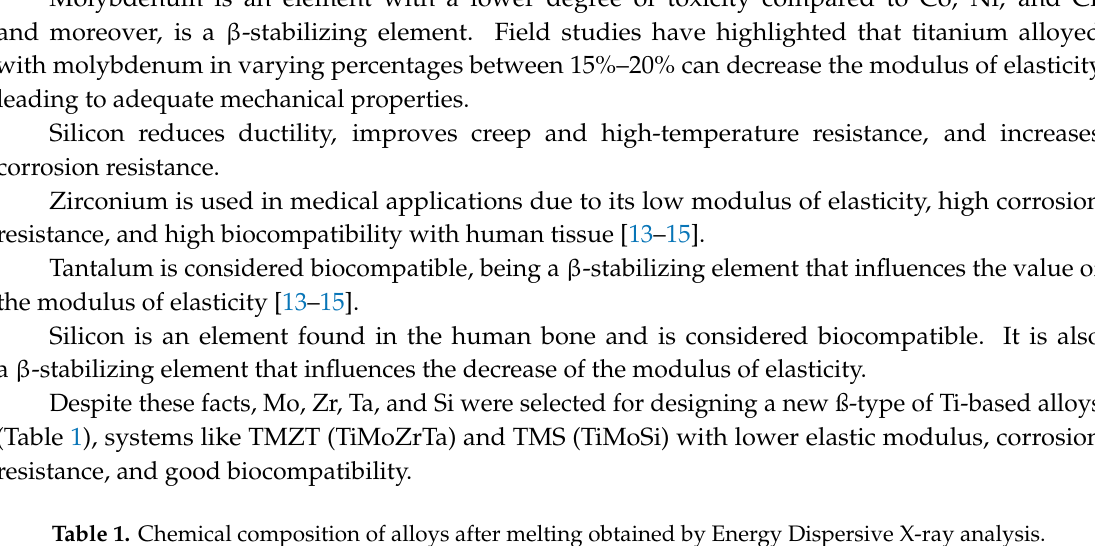
Table 1. Chemical composition of alloys after melting obtained by Energy Dispersive X-ray analysis. Chemical